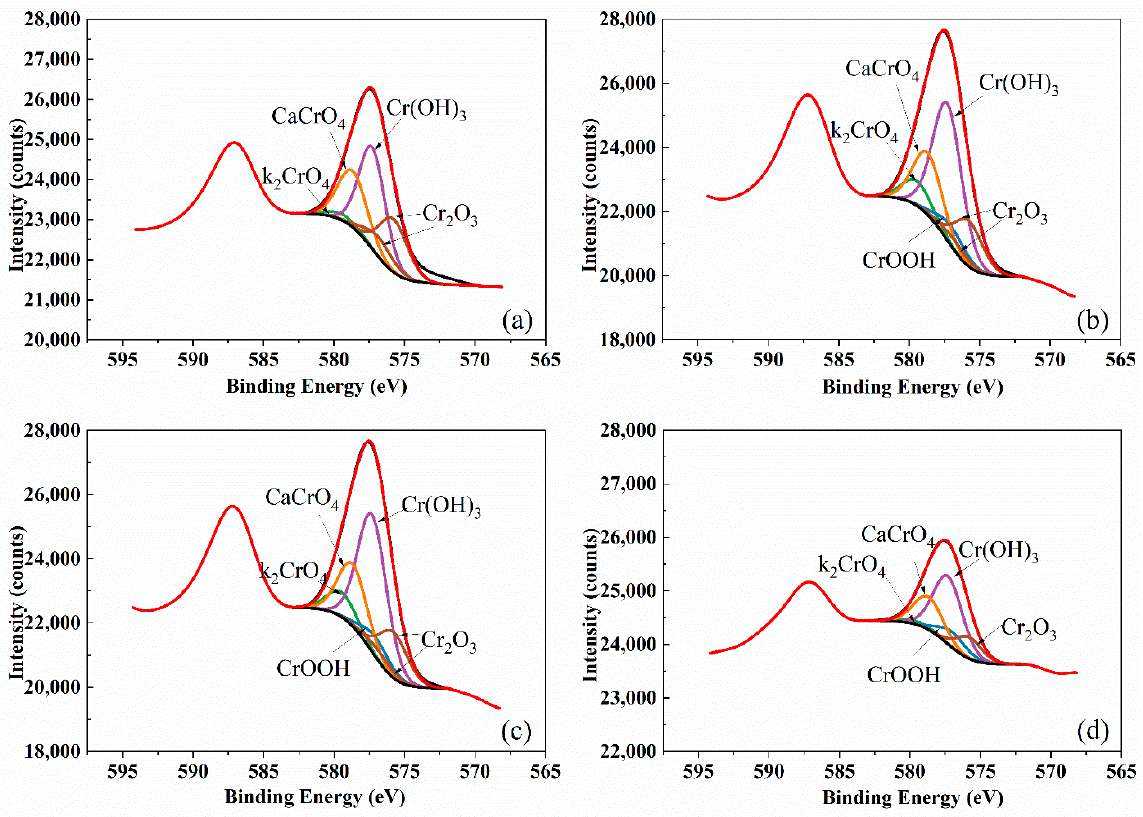
Figure 7. The X-ray photoelectron spectroscopy Cr 2p spectra of the soil samples ( a ) S3-1, ( b ) S3-6, ( c ) S3-7 and ( d ) S5-2.